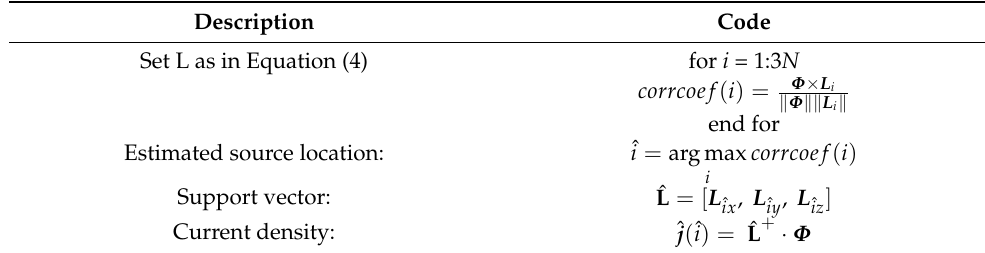
Table 2. Pseudocode of proposed algorithm using matching